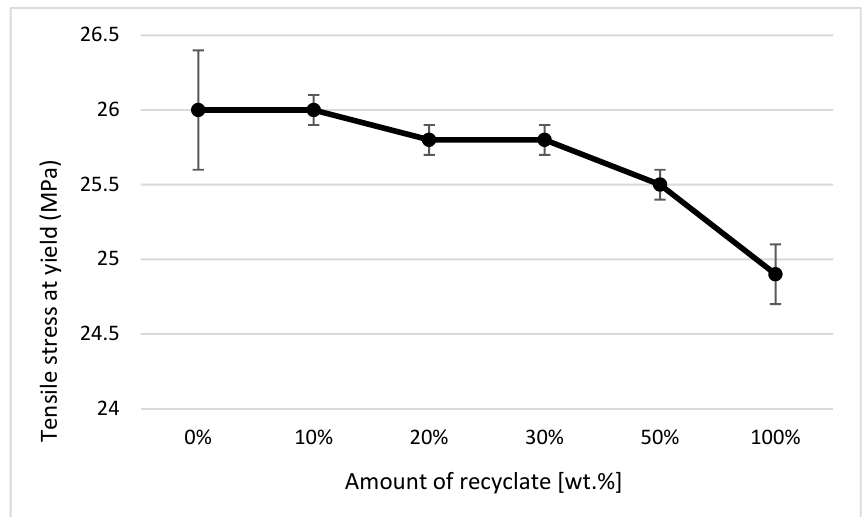
Figure 12. Dependence of yield stress (strength limit) on the proportion of weight of the recycled material before exposure of samples to elevated temperature.